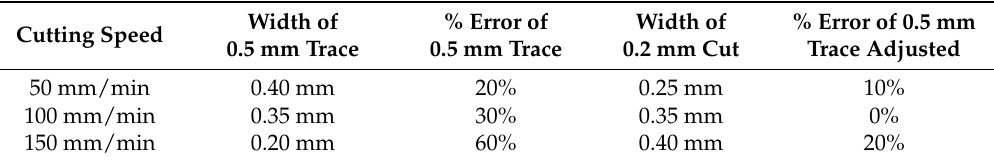
Figure 11. An image of the octagonal shape used to verify feature accuracy. Table 2. A comparison of feature accuracies at different cutting speeds.